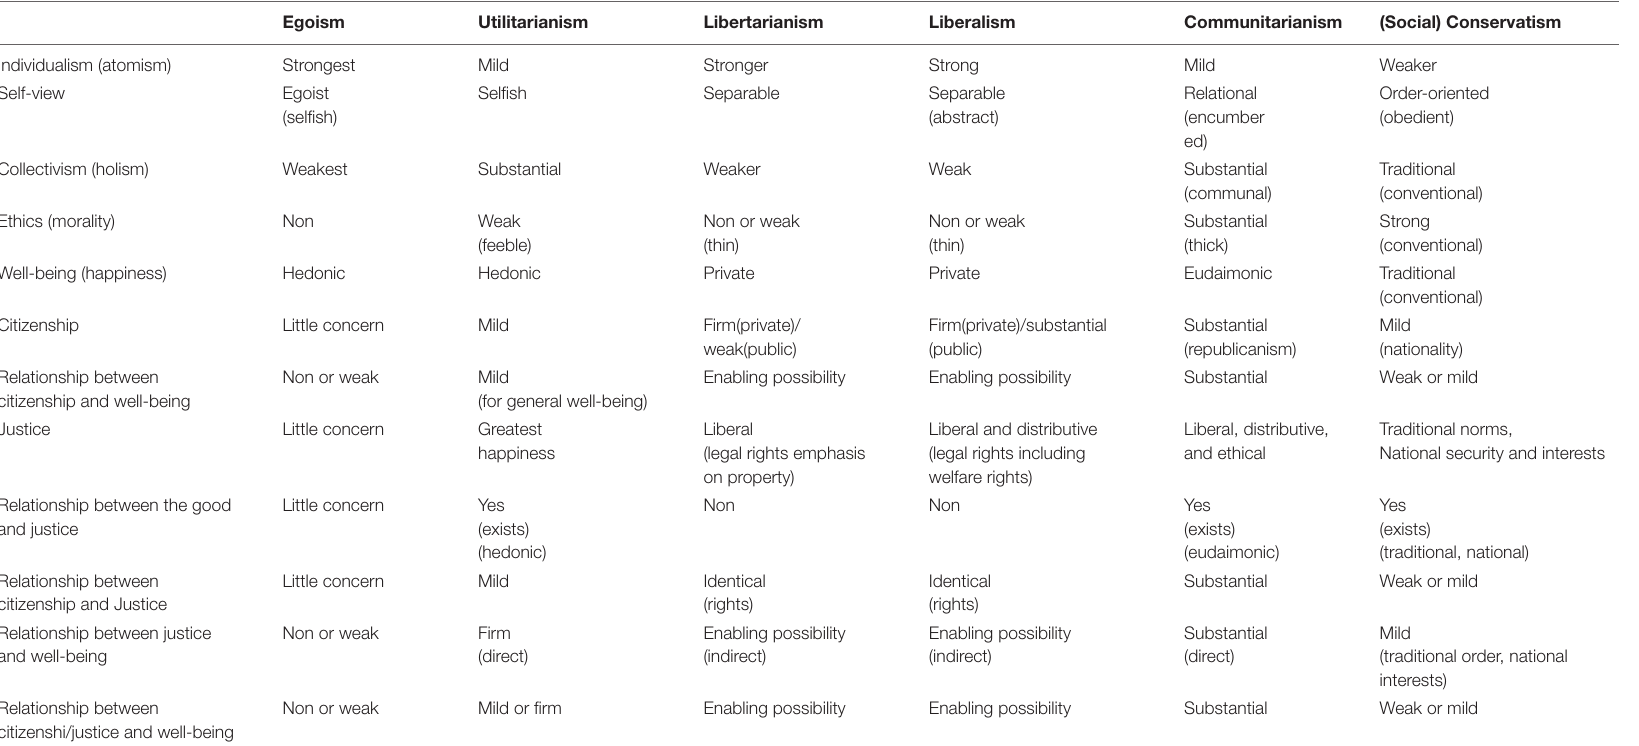
TABLE 1 | Basic characteristics of political